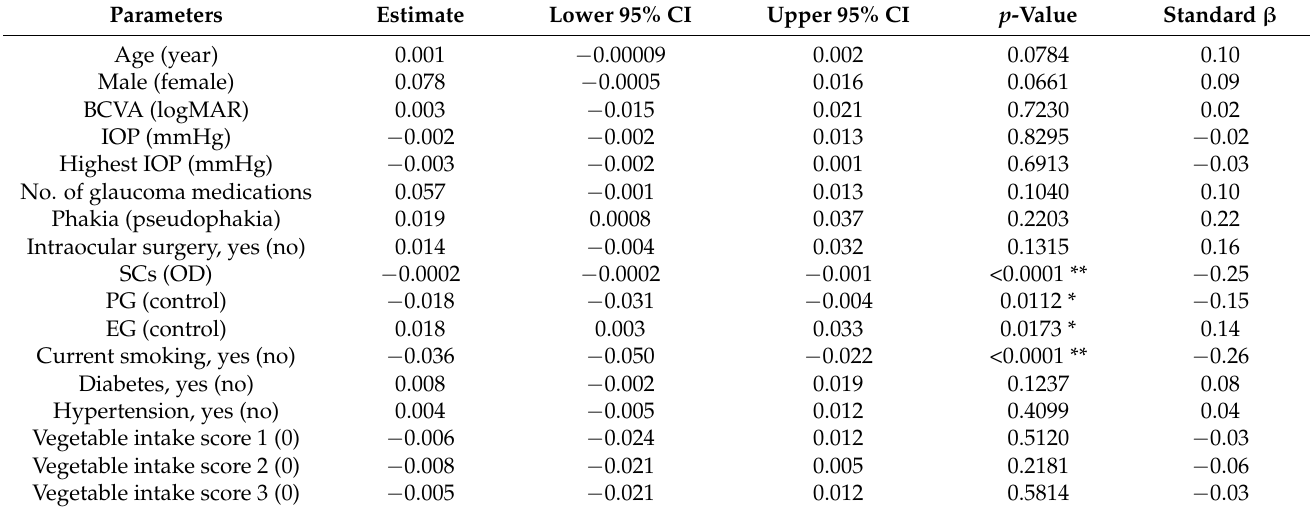
Table 8. Possible associations among AGEs and various parameters analyzed by multiple regression analysis.